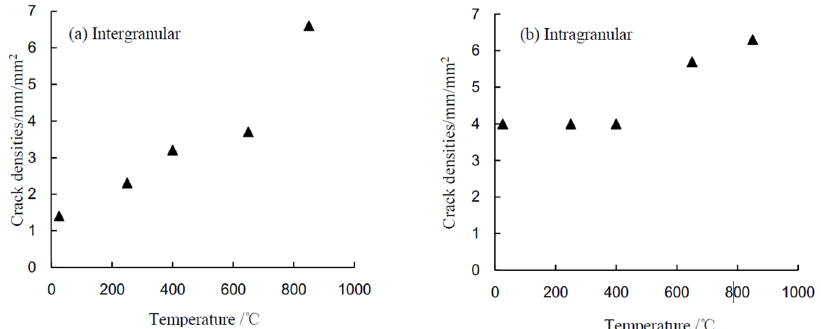
Figure 6. Micro-crack number varies with temperature: ( a ) intergranular; and ( b ) intragranular.